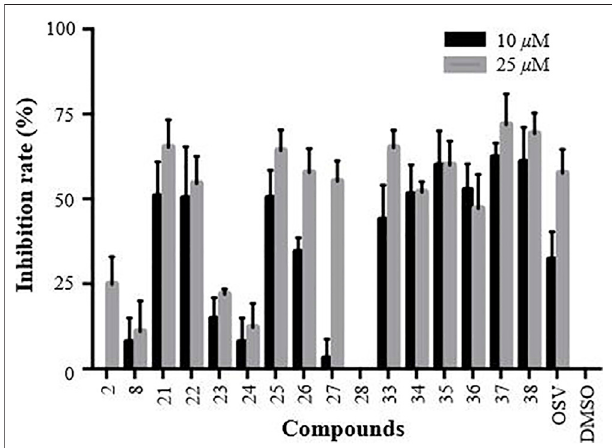
FIGURE4| CPE-basedprimarily screening ofGA( 2 ), β -CD ( 8 ),and their heptavalent β -CD-GAconjugates 21 – 28 and 33 – 38 .MDCK cellswereutilized as the host cells to test A/WSN/33 virus infection; OSV and DMSO acted as positive and negative controls, respectively. Error bars indicate standard deviations of triplicate experiments.